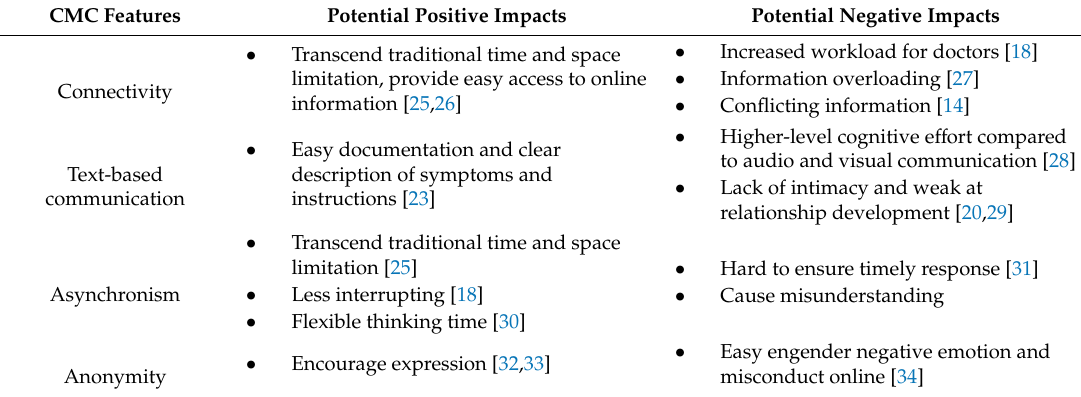
Table 1. The potential positive and negative impacts of each CMC feature on online